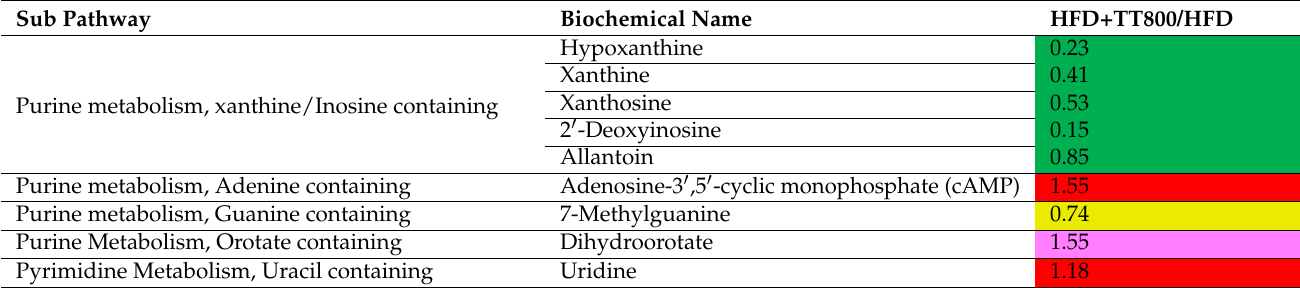
Table 5. Effects of TT supplementation on serum nucleotide metabolites in mice fed HFD compared to the HFD control group. Sub